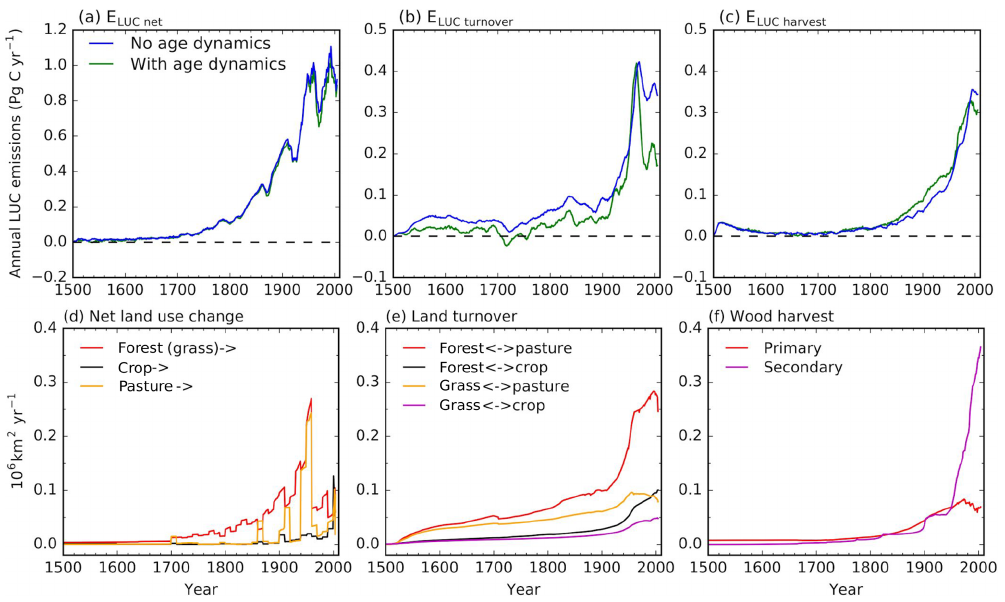
Figure 2. (a–c) Annual carbon emissions since 1501 from different LUC processes, (a) net land use change, (b) land turnover, and (c) wood harvest. Data are smoothed using a 10-year average moving window. (d–f) Annual time series of areas impacted by different LUC processes. (d) Area losses of forest, grassland, cropland, and pasture as a result of net land use change. Note that we assume equal contributions from forest and grassland to agricultural land when backcasting historical land cover maps; thus area losses of forest and grassland are identical. (e) Areas subject to land turnover. (f) Areas of wood harvest from primary and secondary forests.